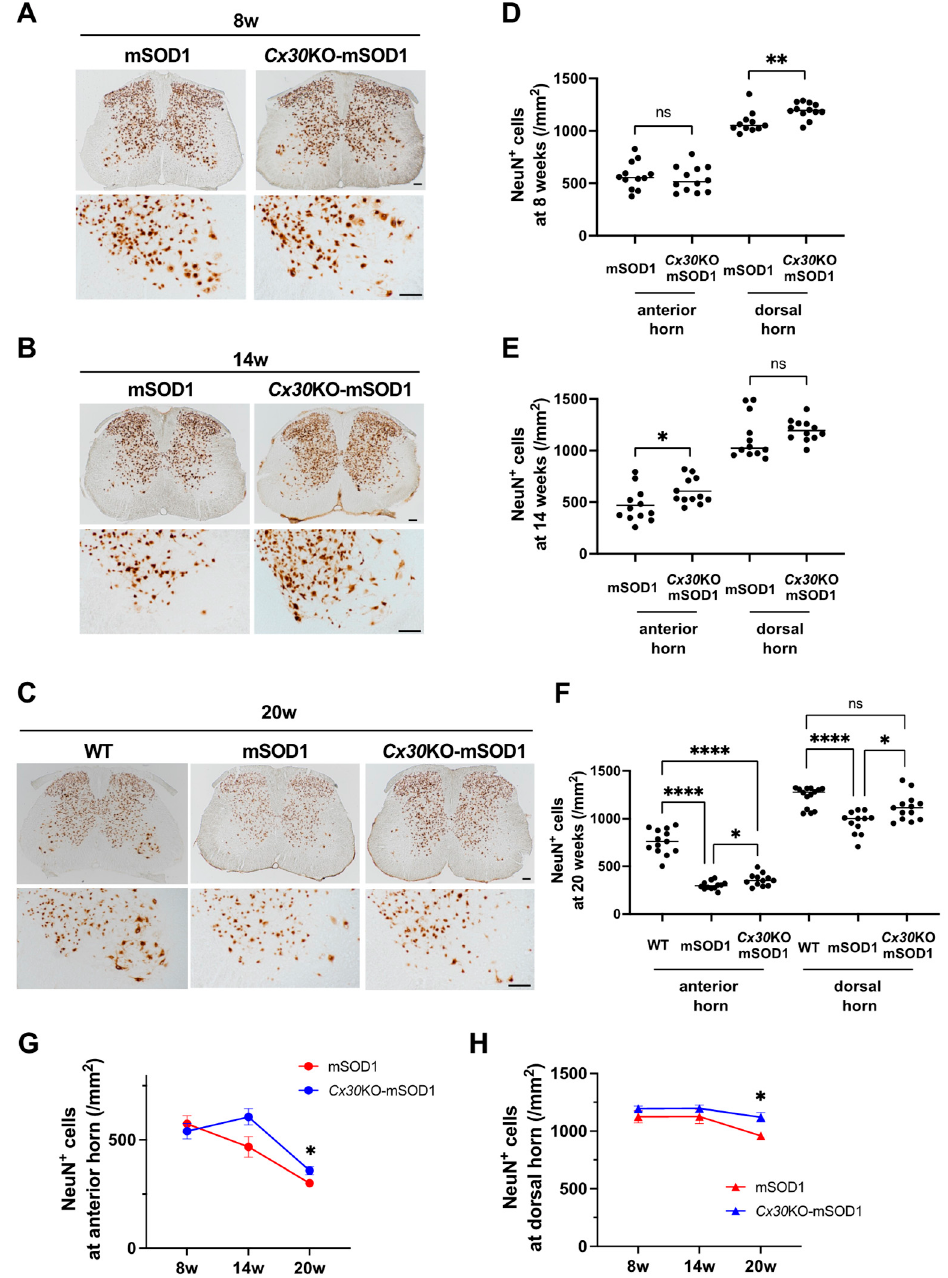
Figure 3. Quantification of lumbar spinal neurons in Cx30 KO-mSOD1 and mSOD1 mice. ( A – C ) NeuN immunostaining of lumbar neurons in Cx30 KO-mSOD1 and mSOD1 mice at 8 weeks (A), 14 weeks ( B ), and 20 weeks ( C ). NeuN immunostaining at 20 weeks includes WT mice ( C ). ( D – F ) Numbers of neurons in the anterior and dorsal horn at each week of age. n = 12 (four slices from every three mice). ( G , H ) Time course of anterior and dorsal horn cell numbers in each group. Red and blue lines show mSOD1 and Cx30 KO-mSOD1 mice, respectively. Scale bars: 100 µ m. Statistical differences were assessed using an unpaired t -test with Welch’s correction for anterior and dorsal horn cell numbers at 8 and 14 weeks. At 20 weeks, Welch’s ANOVA plus Dunnett’s T3 multiple comparison tests were used to analyze anterior and dorsal horn cell numbers. Time course of NeuN + cell numbers was evaluated with two-way ANOVA plus Sidak’s multiple comparison test. ns = not significant. * p < 0.05, ** p < 0.01, and **** p <